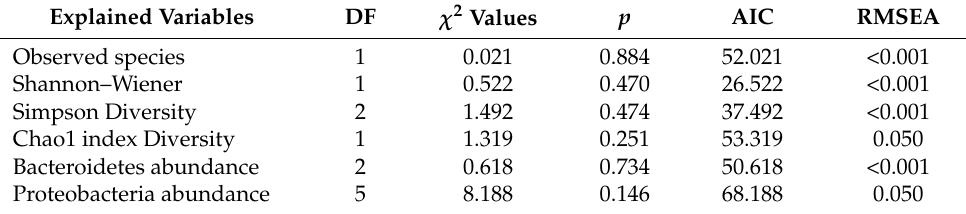
Table 2. The goodness of the best-fitted SEM models to explain the diversity and abundance of microbial community. Models were selected based on significant χ 2 values ( p > 0.05) and lowest AIC